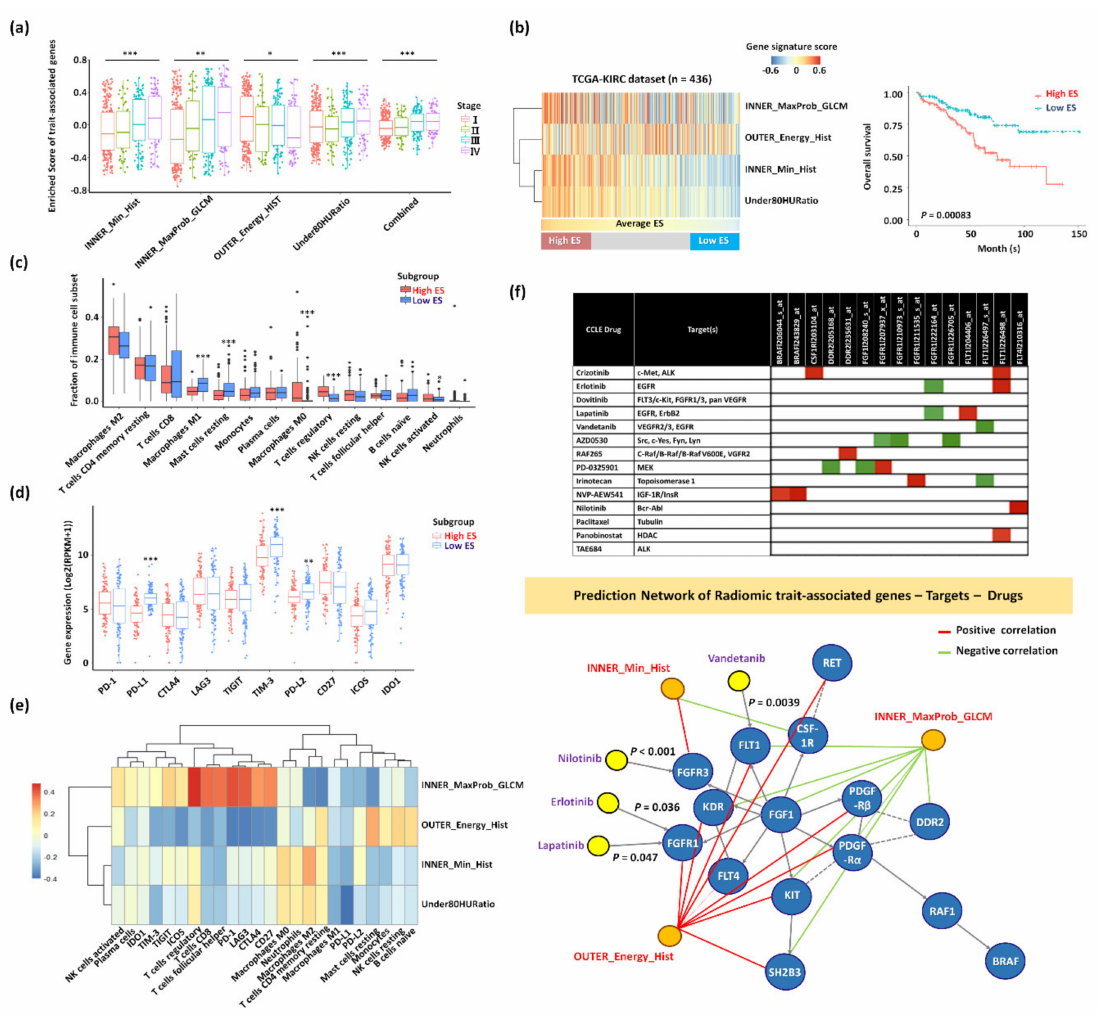
Figure 6. Characterization of subgroups clustered by the expression patterns of trait-associated genes in thegenomicvalidationcohort. ( a )Comparisonofsignaturescoresofeachtrait-associatedgeneaccording to the stage in the TCGA-KIRC dataset ( n = 436). * p < 0.05, ** p < 0.01, *** p < 0.001. ( b ) Three subgroups (high, intermediate, and low enrichment scores (ESs)) of samples according to the expression patterns of the trait-associated genes in the TCGA-KIRC dataset ( n = 436) (left panel). Kaplan–Meier curves of OS are shown for high- and low ESs (right panel). ( c ) Di ff erences in immune-cell-type proportions between the high and low enrichment of radiomic gene-sets. ( d ) Di ff erences in checkpoint modulators between the high and low enrichment of radiomic gene-sets. ( e ) Heatmap of the correlation between each trait-associated gene-set and immune-cell-type proportions / checkpoint modulators. ( f ) upper panel: Association between candidate drugs and target genes in kidney cell lines from the Cancer Cell Line Encyclopedia (CCLE) dataset. The correlation map of anticancer drugs and genes belonged to major pathways. The red color indicates a positive correlation between gene expression and the half-maximal e ff ective concentration (EC50, corresponding to less e ff ective drug), and the green color indicates a negative correlation between gene expression and EC50 (corresponding to more e ff ective drug). lower panel: Gene–drug–radiomic feature Network. A directed edge between genes represents activation or catalysis, and a dotted edge indicates the predicted functional